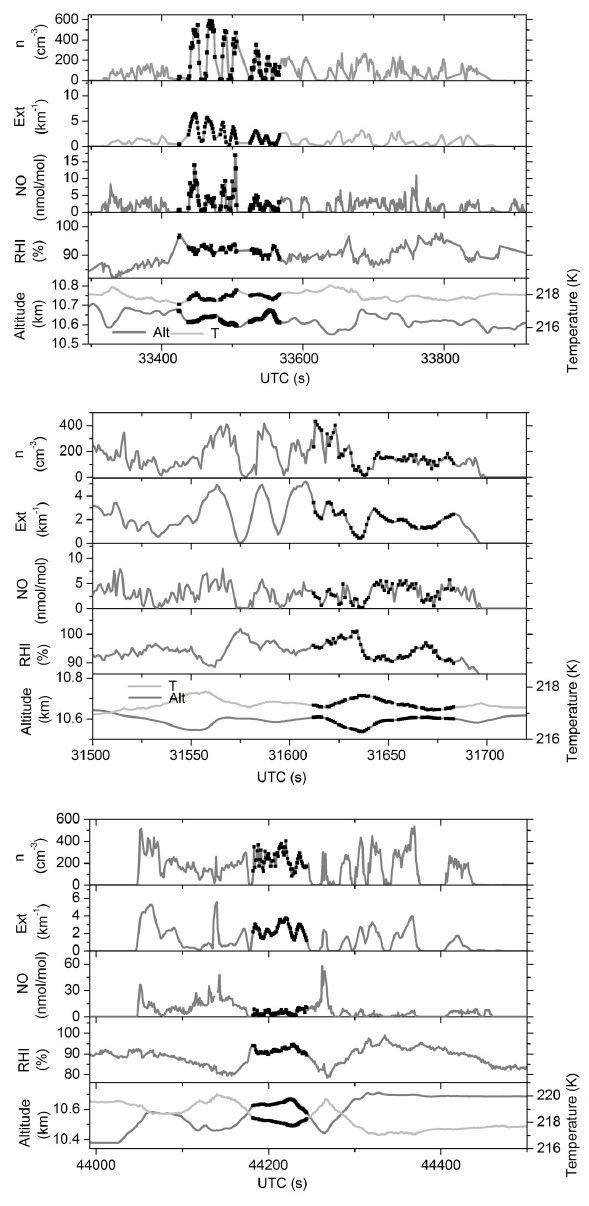
Fig. 1. Probing contrails from three aircraft (top: A319, middle: A340 and bottom: A380) on 19 November 2008 above Germany. The photos are taken from the cockpit of DLR research aircraft Fal- con. The nose boom of the Falcon is visible in the top photo.